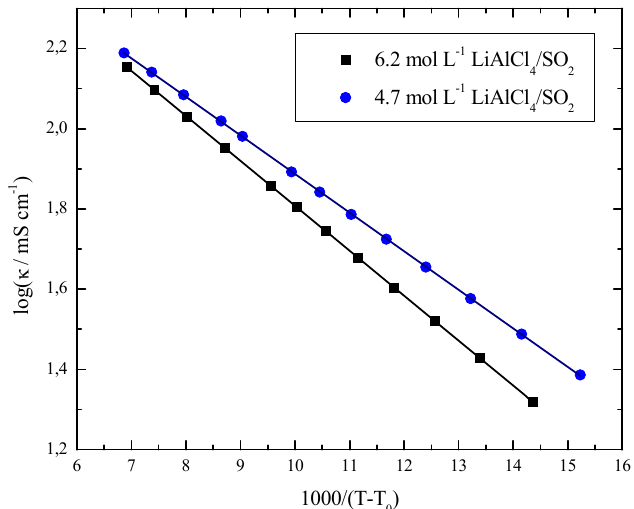
in SO and linear 4 2